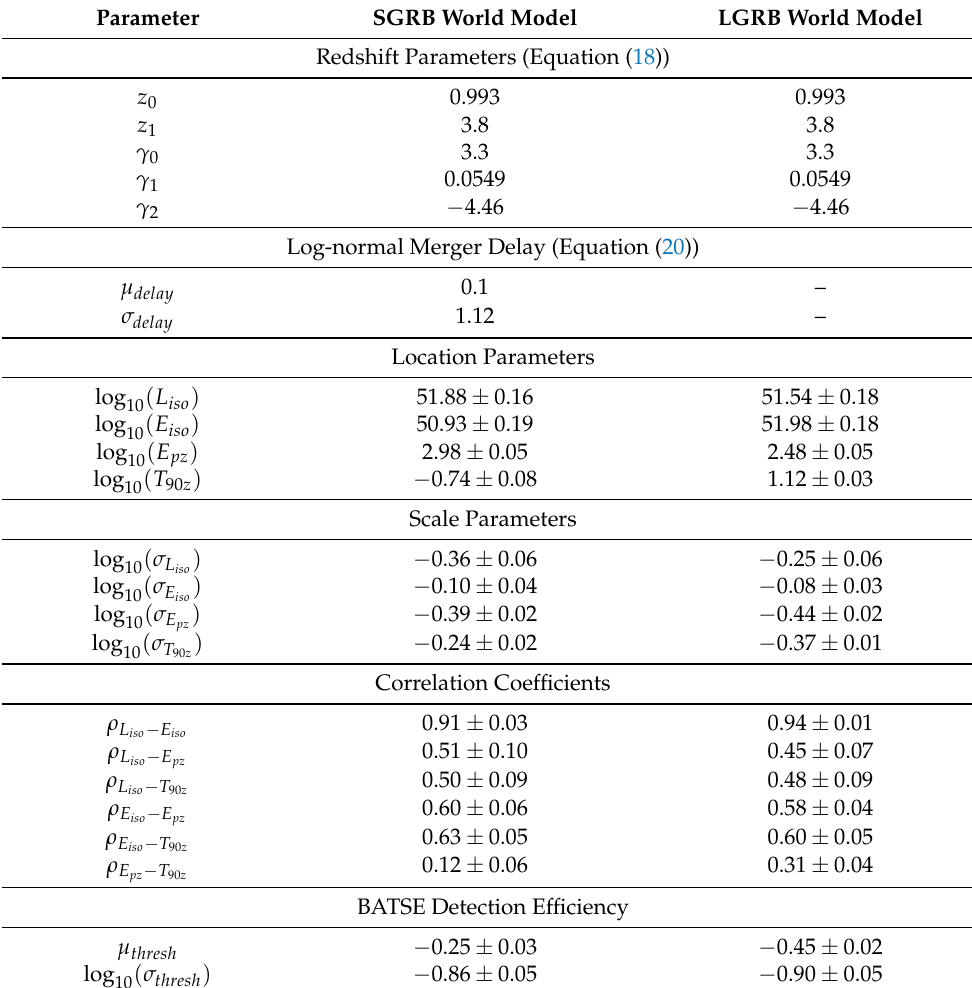
Table 1. Mean best-fit parameters of SGRB world model compared to LGRB world model of Shah- moradi